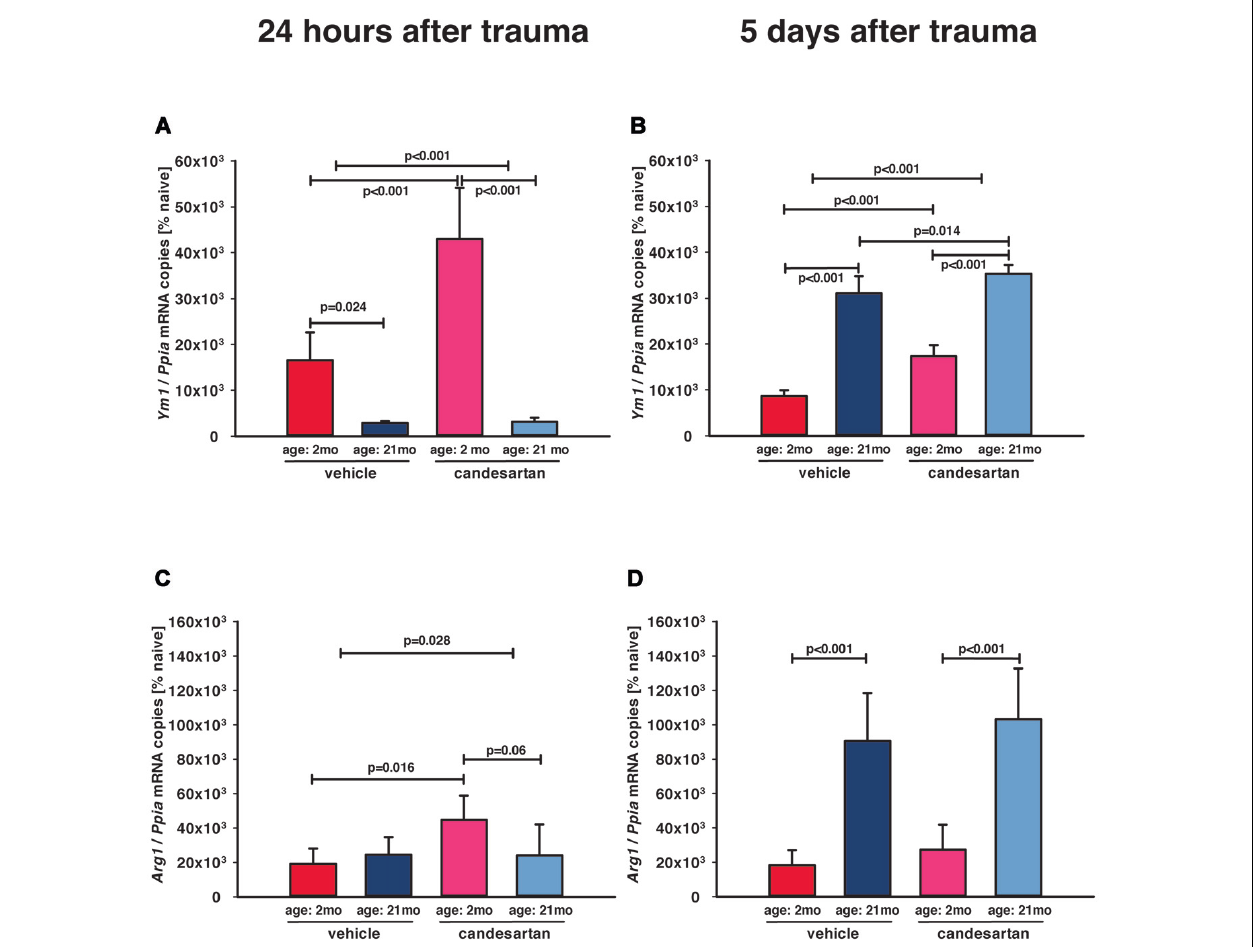
FIGURE 5 | Influence of AT1 inhibition on posttraumatic expression of M2a microglia markers. Anti-inflammatory M2a polarization of microglia was assessed with the M2a markers arginase ( Arg1 ) and chitinase-like protein 3 ( Ym1 ) in the ipsilateral hemisphere by qPCR in young and old naïve animals ( n = 6 each), 24 h after insult [ A, C ; candesartan: young ( n = 8); old ( n = 7) or vehicle young ( n = 8); old ( n = 7)], and 5 days after injury [ B, D ; young: vehicle and candesartan ( n = 8 each); old: vehicle ( n = 10; seven survived) and candesartan ( n = 8; seven survived)]. In young mice, there was an early increase of Ym1 expression. AT1 inhibition